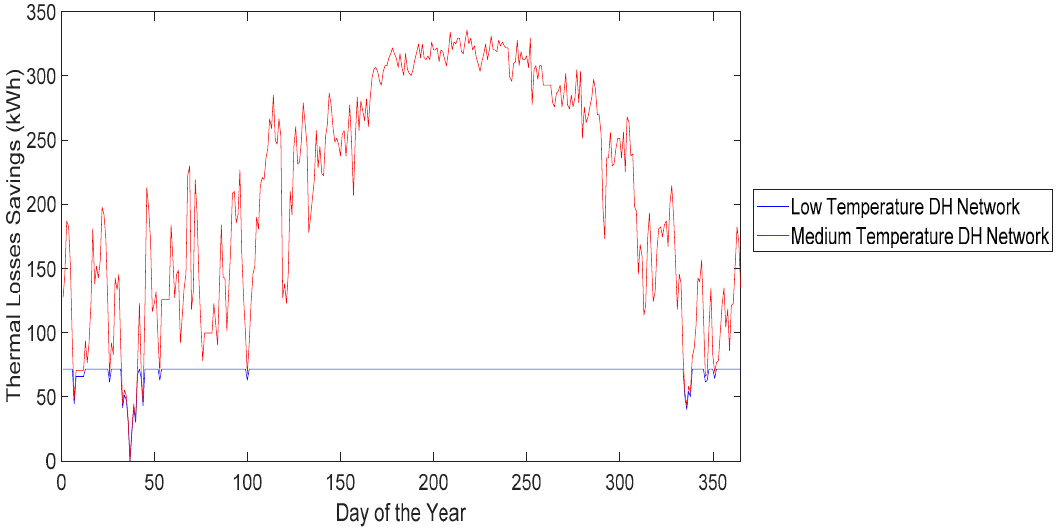
Figure 10. Energy savings in low and medium temperature networks operating at variable network temperatures.